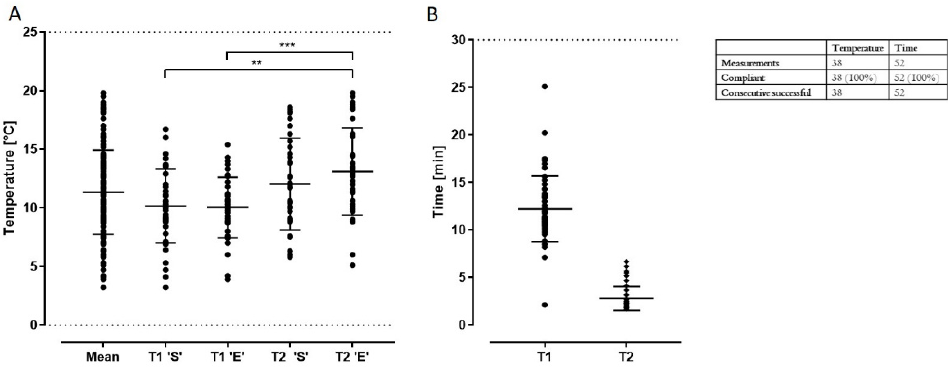
Figure 11. Transport validation. ( A ) The graph shows the temperature in the transport box for biopsies transported from the laboratory to the LTTC (T1) and tIPEs from the LTTC to the laboratory (T2). Note the temperature increase during transport remained within acceptable limits (T1 ′ S ′ vs. T2 ′ E ′ : p = 0.0013, **; T1 ′ E ′ vs. T2 ′ E ′ : p = 0.0007, ***). ( B ) The mean duration of both, T1 and T2 was within the accepted range of 30 min. Temperature was recorded for 38 and time for 52 transports of which 100% were conforming. S = start of transport; T = end of transport.